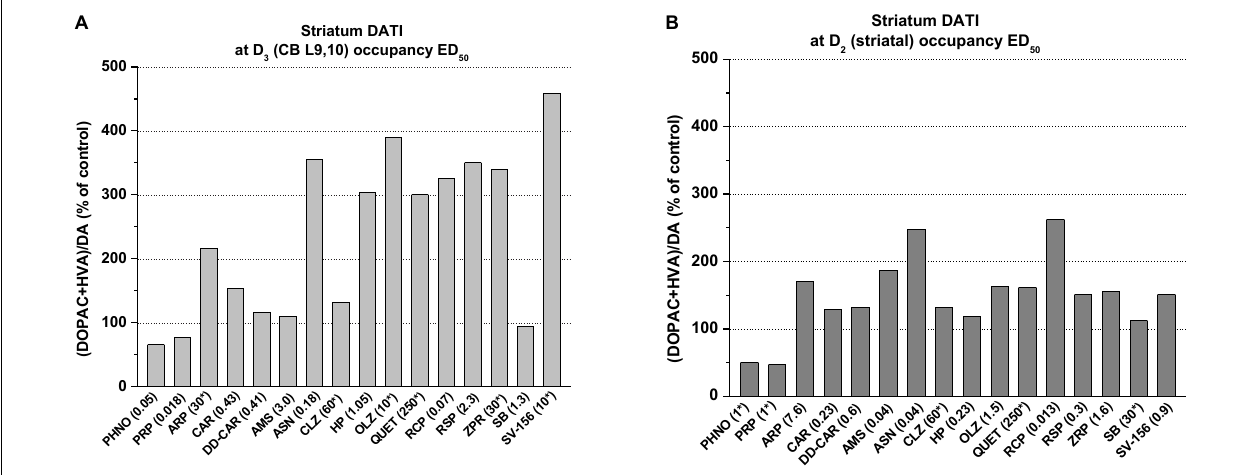
FIGURE 5 | Graphical presentation of percent changes in striatal dopamine turnover indices (DATI) at D 3 R (i.e., cerebellar L9, 10) occupancy ED 50 doses (A) and at D 2 R (i.e., striatal) occupancy ED 50 doses (B) in vivo ∗ , # . *Doses in brackets denote the occupancy ED 50 doses (or close to ED 50 ) taken from Table 2 . Dopamine turnover index (DATI) was estimated from turnover dose-response curves (consisting of at least 4–5 doses, with five rats in each dose-group) for individual compounds listed in this figure. In cases where the occupancy ED 50 values could not be exactly calculated (see Table 2 ) the turnover indices were determined at doses denoted with asterisks. Dopamine turnover index was defined as DA/(DOPAC+HVA). Determination of tissue dopamine, DOPAC and HVA was carried out exactly as described in Kiss et al. (22) (for abbreviations of drugs’ names, see Table 2 ). # Dopamine turnover data for cariprazine and DD-CAR were published in Kiss et al. (173). Turnover results of other compounds are unpublished and are on file at G. Richter. Plc.